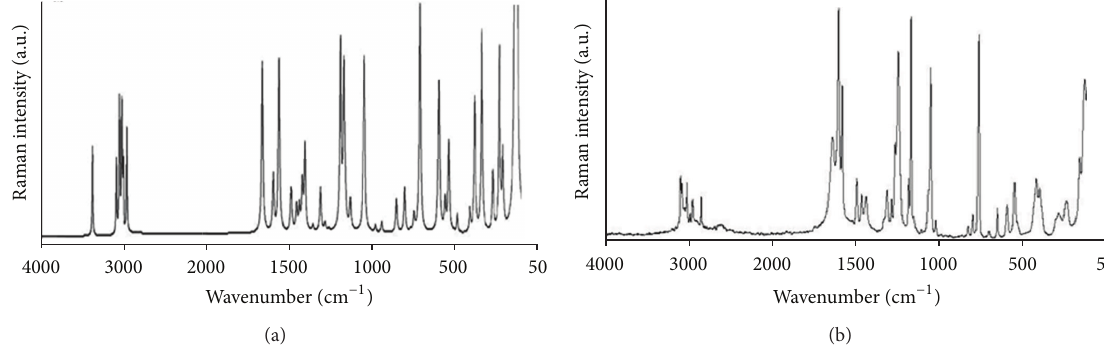
Figure 3: FT-Raman spectra of O-Anisic acid (a) observed and (b) calculated with B3LYP/6-31G ∗∗ .